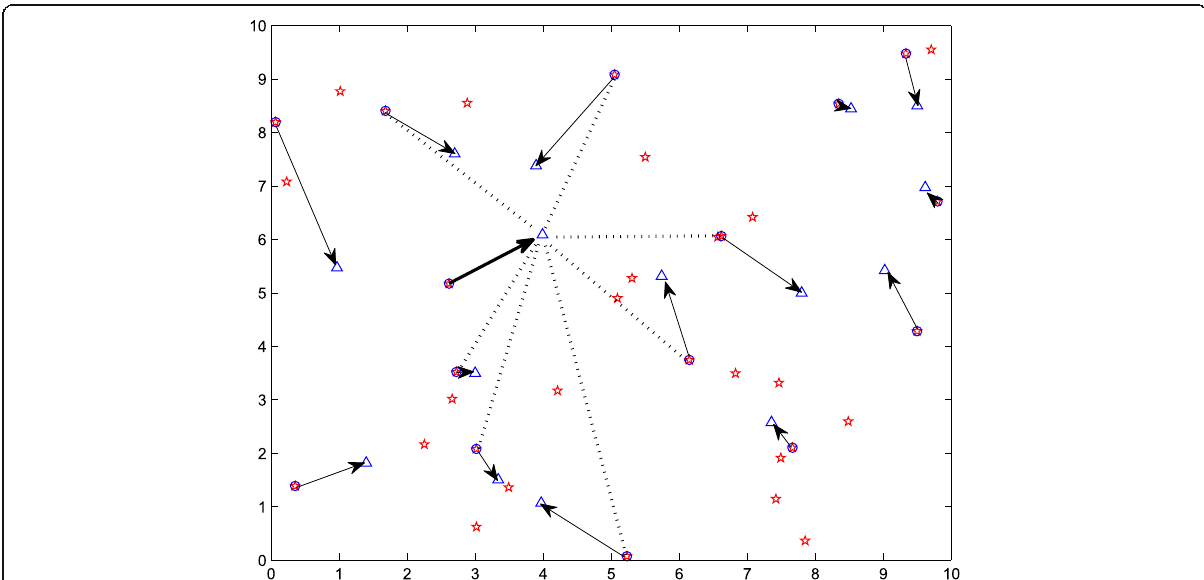
Fig. 3 Model of transmitters, receivers and corresponding links. The red stars are the potential transmitters distributed as a PPP, the blue circles are the concurrently transmitting nodes by CSMA protocol, and the blue triangles are the receivers distributed as another PPP. Solid arrows are the intended links, and dotted lines denote some of the interference